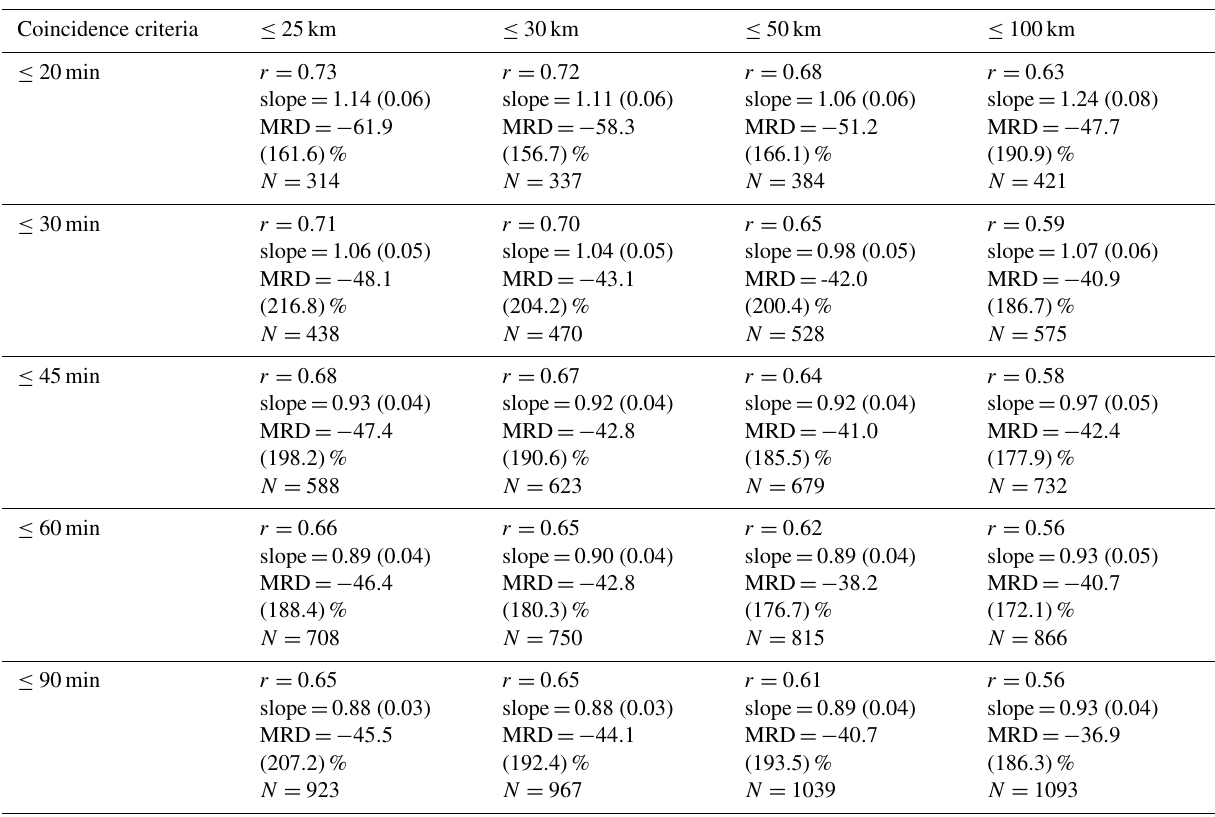
Table 3. IASI vs. TAO FTIR correlation coefficient, slope (regression standard error in parenthesis), MRD (1 σ rms in parenthesis) (in %), and number of data points, calculated for each TAO FTIR measurement, for varying spatial and temporal coincidence criteria.